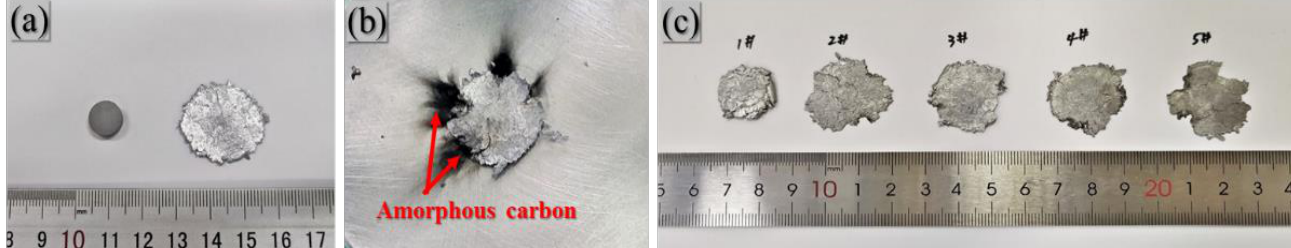
Figure 6. Reaction delay of reactive material under drop-hammer test.